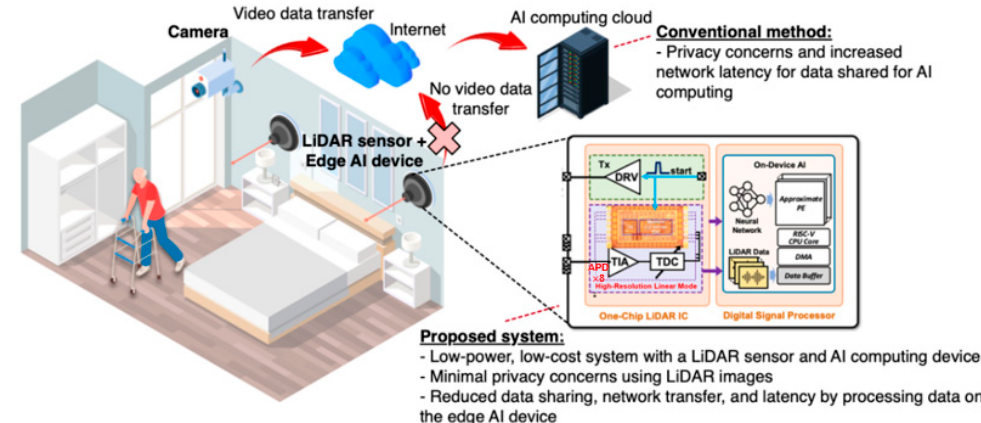
Figure 2. Feasible usage of the proposed indoor-monitoring LiDAR sensor equipped in a living room of LTCF.